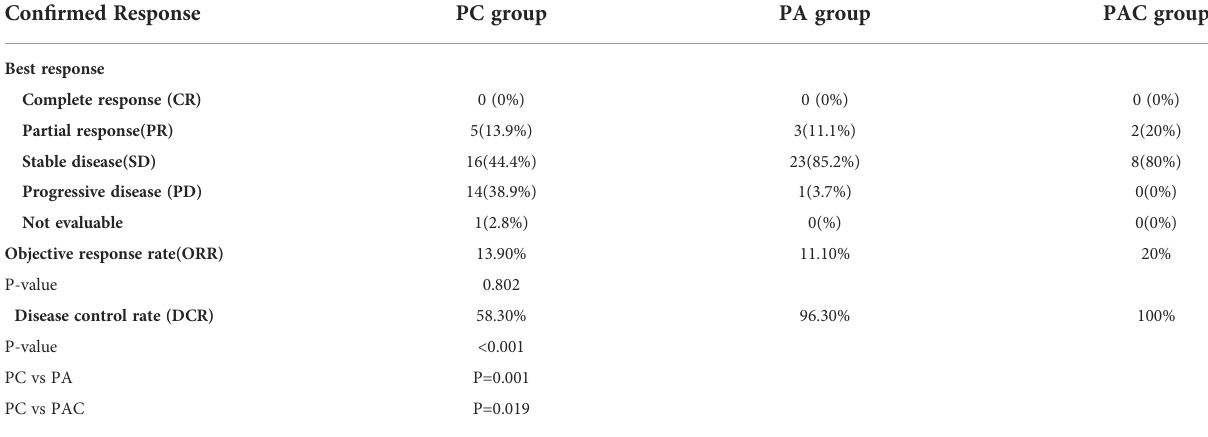
TABLE 6 Summary of con fi rmed response assessed by RECIST version